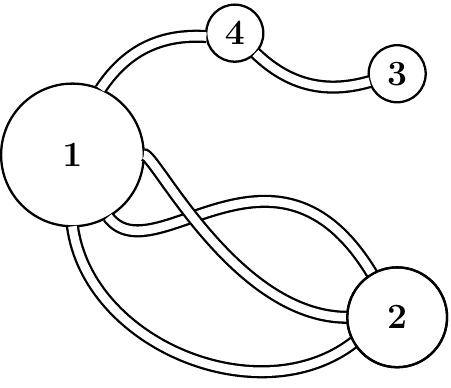
Figure 12 . Minimal graph example with n = 4 and g =